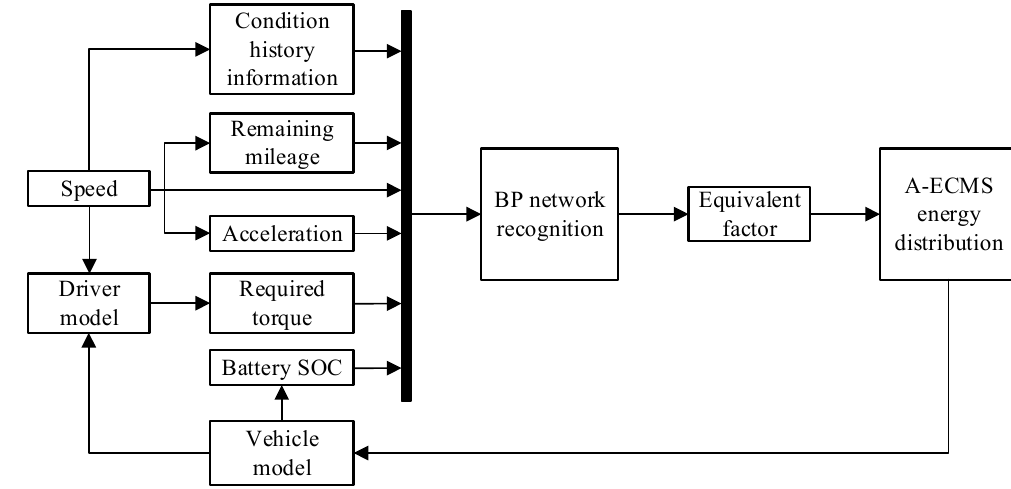
Figure 9. Online controller based on the back propagation (BP) neural network.